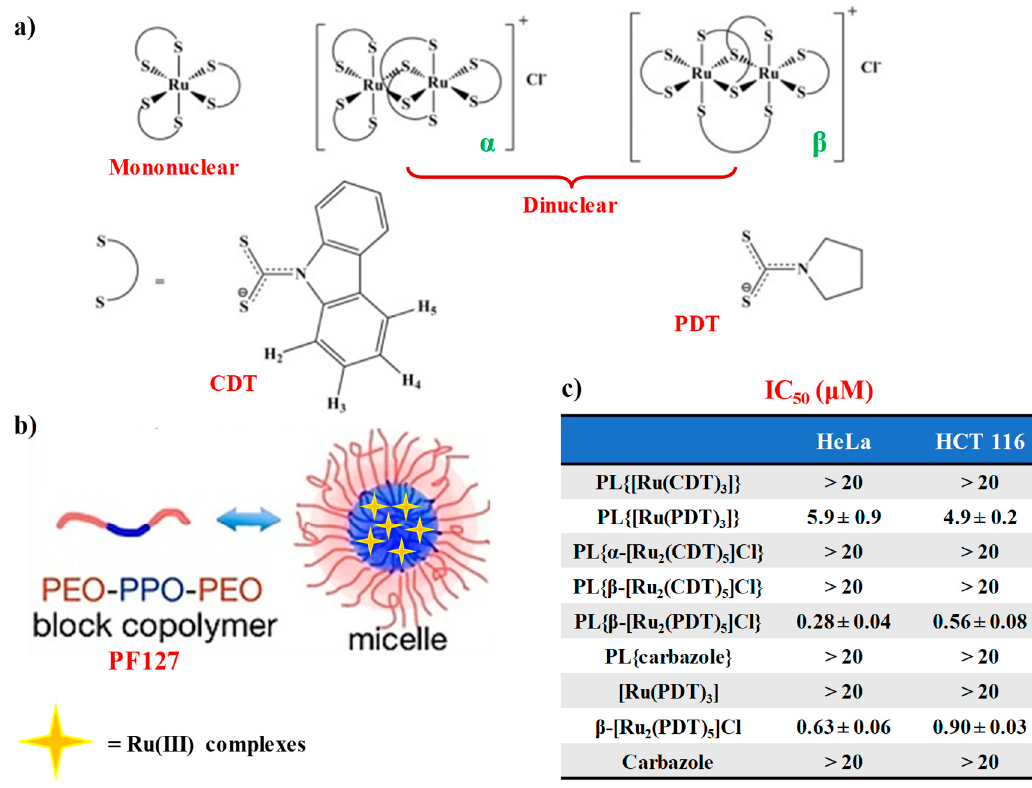
Figure 6. ( a ) Chemical structures of mononuclear and dinuclear Ru(III)-dithiocarbamato complexes and of the investigated dithiocarbamato ligands: pyrrolidyl dithiocarbamate (PDT) and carbazolyl dithiocarbamate (CDT); ( b ) schematic representation of the Pluronic ® F127 block copolymer and micelle formation with Ru(III) complex internalization; ( c ) IC 50 values (µM) evaluated after 72 h treatment with free Ru(III)-dithiocarbamato complexes and their micelles formulations (indicated as PL{compound}). IC 50 values are reported as mean ± SEM. Figures are adapted from [117].